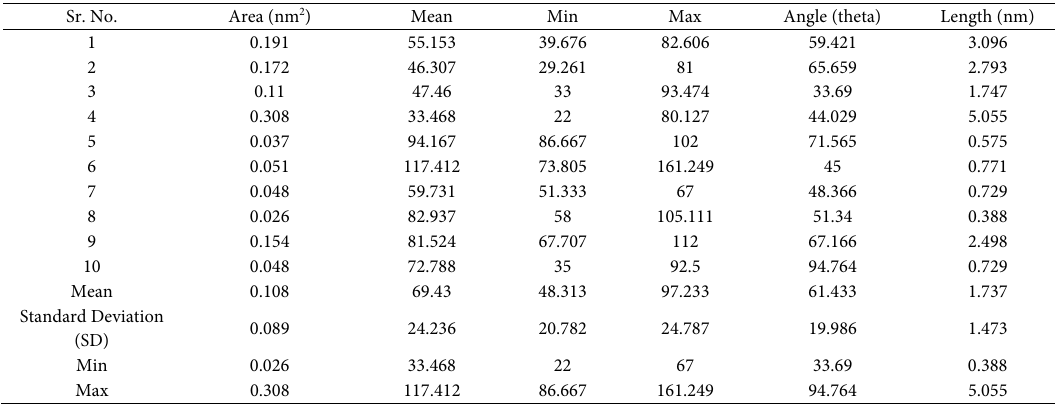
Table 5. FESEM Parameters of Raw Wheat Straw